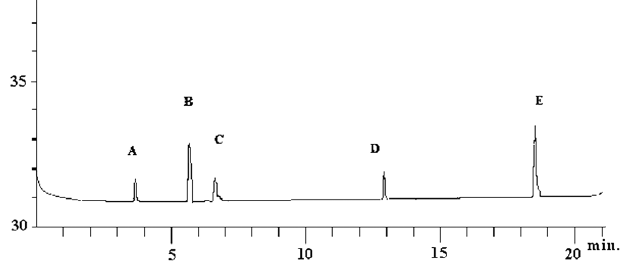
FIGURE 2 - Typical chromatogram showing retention time for different residual solvents. A-methanol, B-acetone, C-DCM, D-cyclohexane,